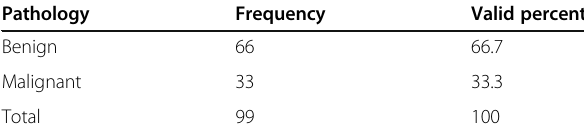
Table 6 Showing the pathological results after FNAC ± surgery Pathology